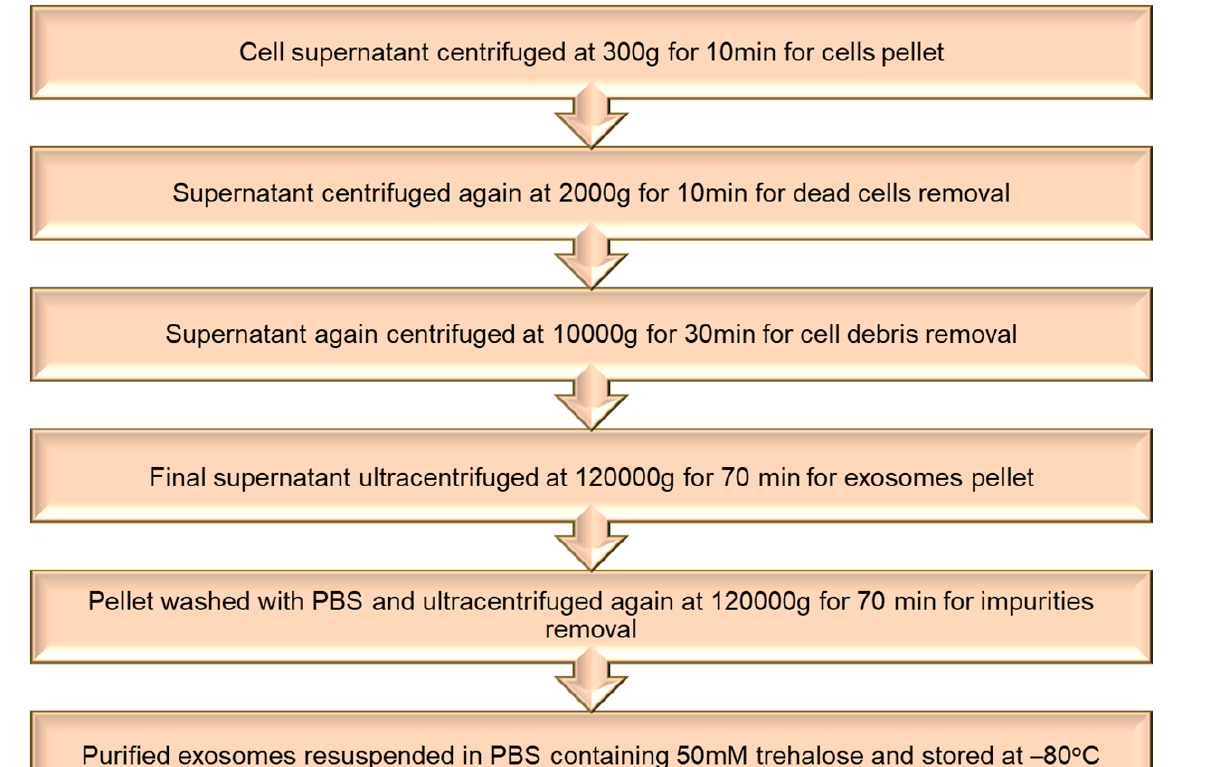
Figure 5. Isolation of